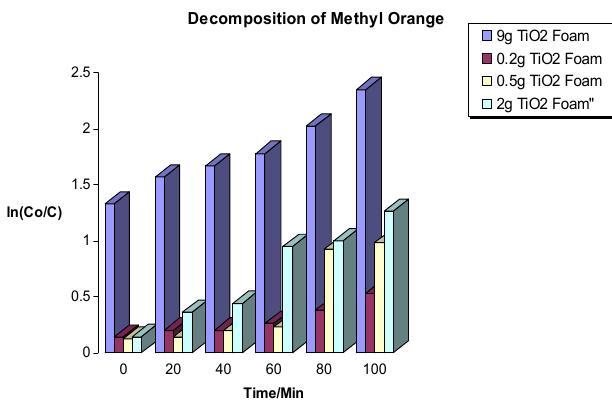
Figure 6. The photocatalytic activity of TiO foam and surface modified binary oxide 2 nanoparticles [8,86]. As expected, a higher catalyst concentration results in increased photocatalytic efficiency until a maximum catalyst loading is